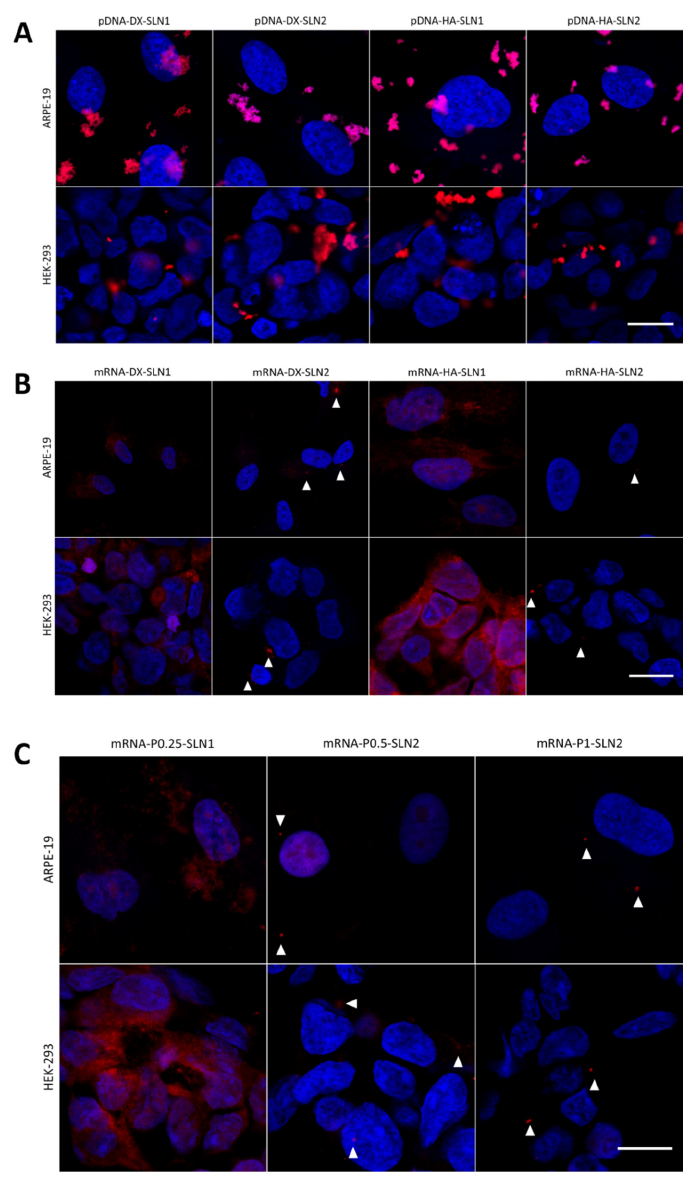
Figure 7. Fluorescence microscopy images 4 h after the addition of SLN1- and SLN2-based vectors in ARPE-19 and HEK-293 cells. ( A ) pcDNA3-EGFP plasmid labeled with Label IT ® Cy ® 5 vectors. ( B ) CleanCap ™ Cyanine 5 EGFP mRNA (5moU) vectors formulated with P, DX and HA. ( C ) CleanCap ™ Cyanine 5 EGFP mRNA (5moU) vectors formulated with P. Nuclei were labeled with DAPI (blue). Magnification 60 × . Scale bar: 15 µ m. White triangles indicate the mRNA. InARPE-19cells,thedispositionofpDNAwassimilarwithallformulations. However,inHEK-293cells, pDNA dots were smaller with the vectors DX-SLN1 and